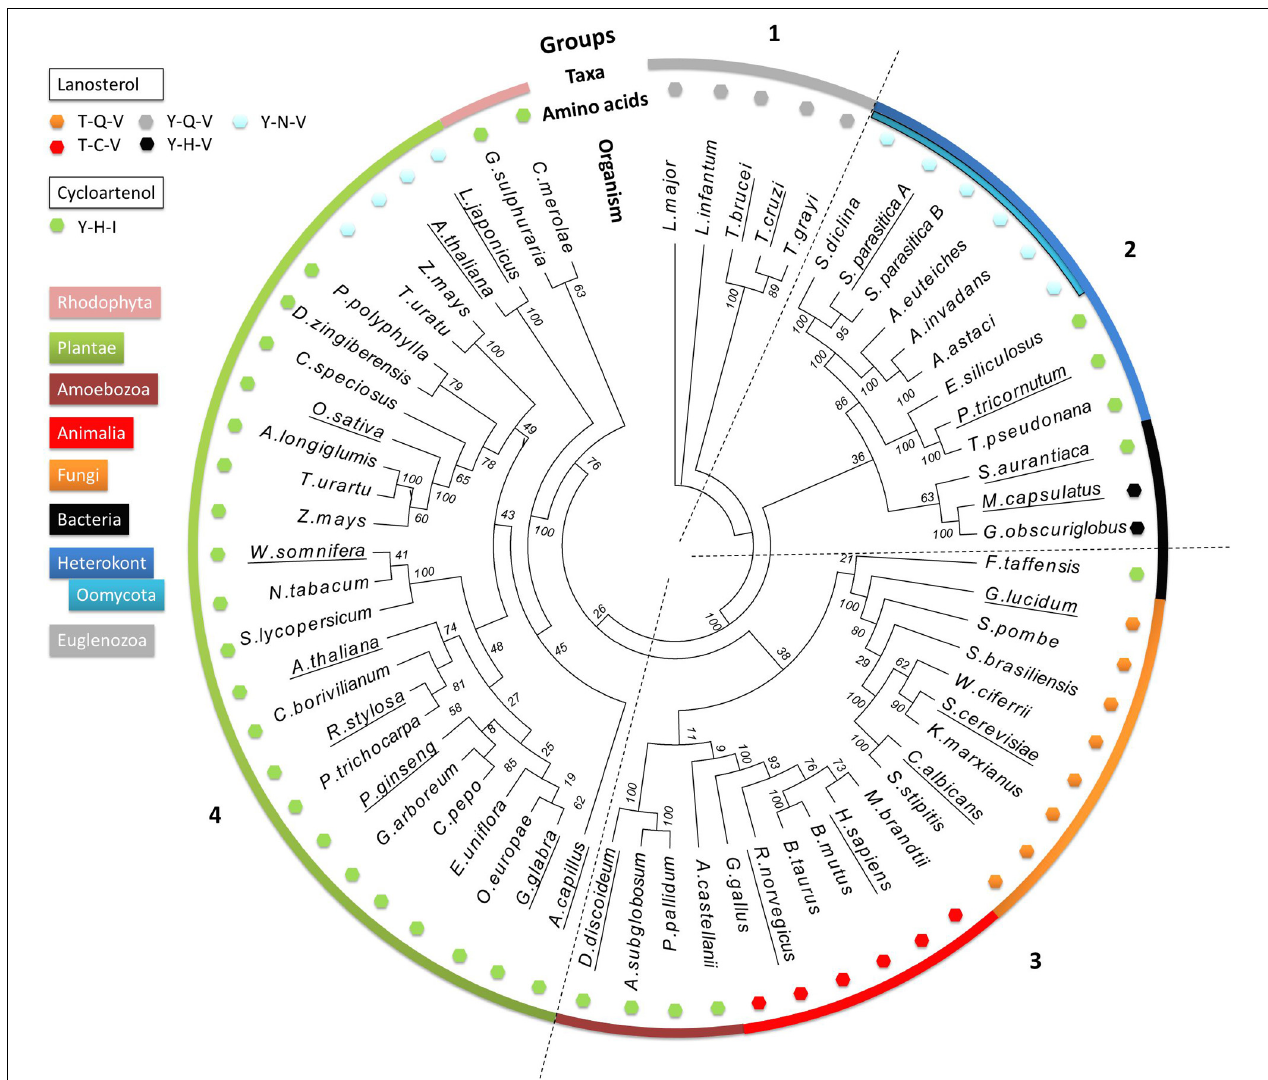
FIGURE 3 | Phylogenetic analysis of 63 characterized and predicted OSC sequences. Species group into four clades, numbered 1–4. The outer colored ring denotes the taxonomic groups of the species from which the sequences originate, as indicated by the color key. The small colored hexagons each correspond to a different triad amino acid pattern. The names of the species for which enzyme specificity has been biochemically demonstrated are underlined. Bootstrap values from 100 replicate analyses are shown at each root branch. Full organism names and sequence identification numbers are listed in Supplementary Table